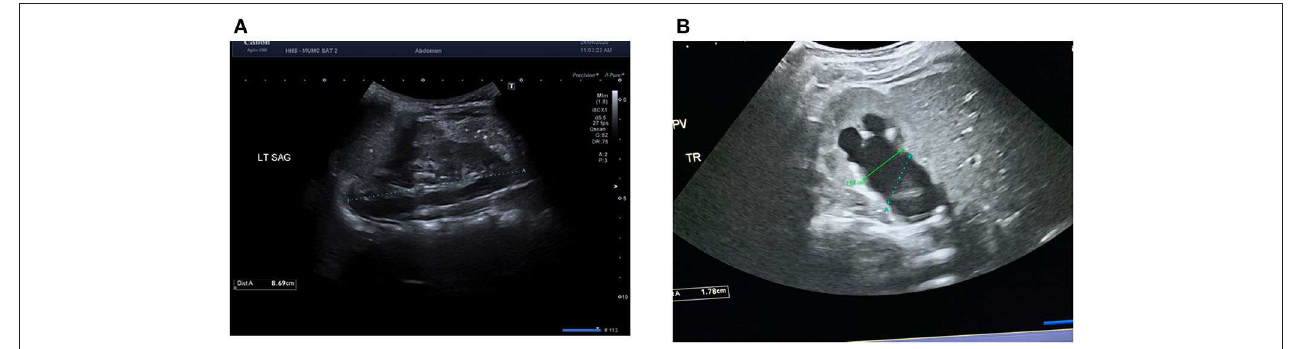
FIGURE 1 | Example measurements of ultrasound renal parameters for the Pyeloplasty Prediction Score in (A) longitudinal view of the left kidney with electronic calipers measuring renal length as the maximal distance between the upper and lower poles and (B) transverse view of the right kidney with green electronic calipers measuring true anteroposterior diameter (APD) as the distance between the parenchymal lips at the renal hilum in the mid-section. Blue electronic calipers represent the incorrect method of measuring APD as the calipers are not aligned to the parenchymal